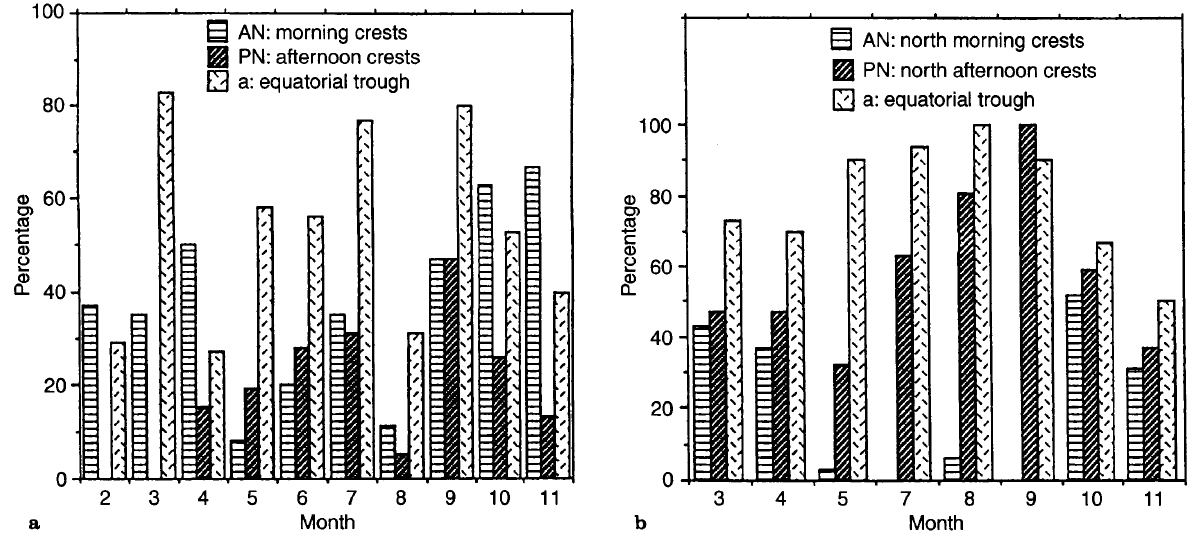
Fig. 7. a Monthly abundance percentages of crest and trough types in 1993, b same percentages